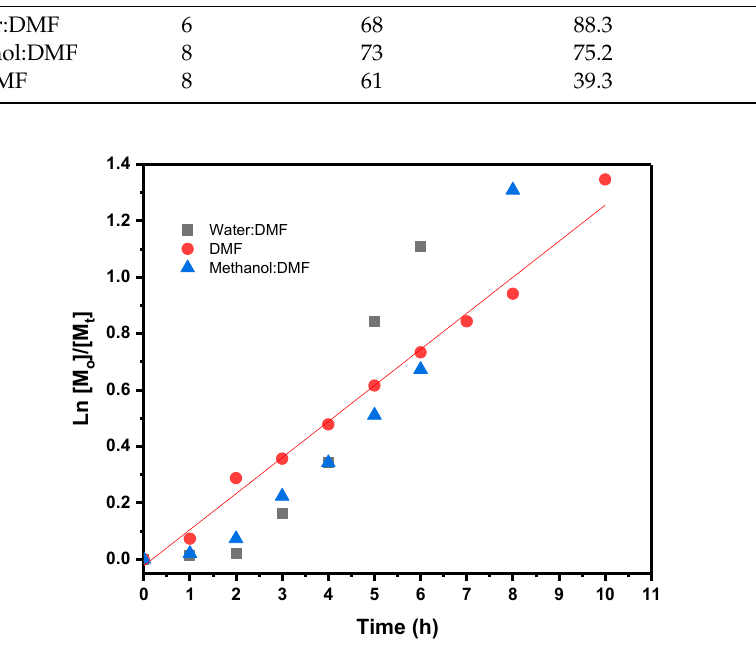
Figure 2. Kinetic plot of poly(2-acrylamido-2-methyl-1-propanesulfonic acid) (PAMPS) synthesized by [Ru(o-C 6 H 4 -2-py)(phen)(MeCN) 2 ]PF 6 in different solvents.